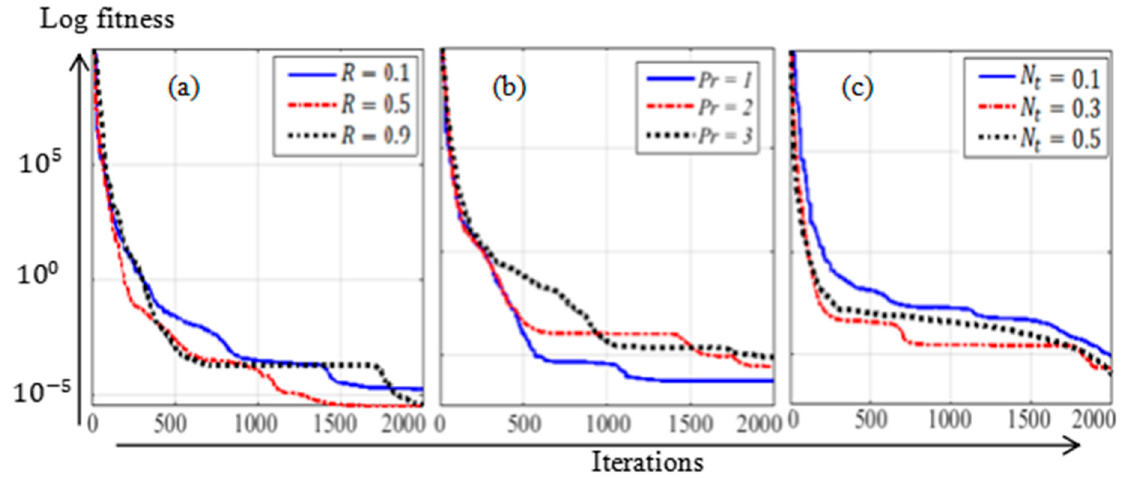
Figure 8. Convergence curves of optimization process for temperature field with respect to variations in ( a ) Radiation parameter ( b ) Prandtl number ( c ) Thermophoresis parameter. The impact of radiation parameter ( R ) on temperature field is plotted in Figure 9. The physical behavior of fluid is greatly affected by variations in the thermal radiation parameter. The incremental values of the parameter of thermal radiation support internal heat energy during the flow. Due to this, the temperature profile is driven to increase. The graphical view of impact of Prandtl number ( Pr ) on temperature profile is presented in Figure 10. It can be observed that the increasing values of Pr have reverse influence on temperature profile. Figure 11 demonstrates that the increase in values of thermophoresis parameter ( N t ) impacts the temperature